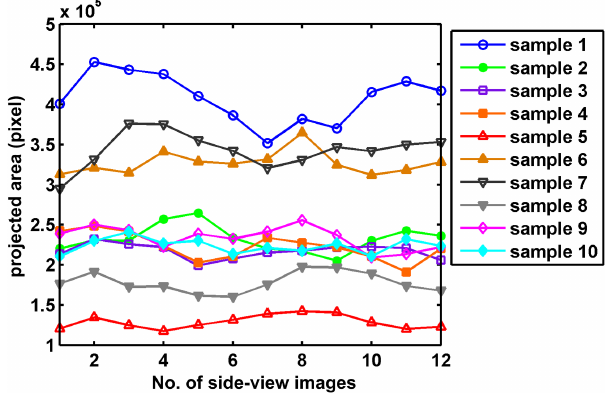
Fig. 5. The curves of the projected areas in each side-view image for 10 randomly selected